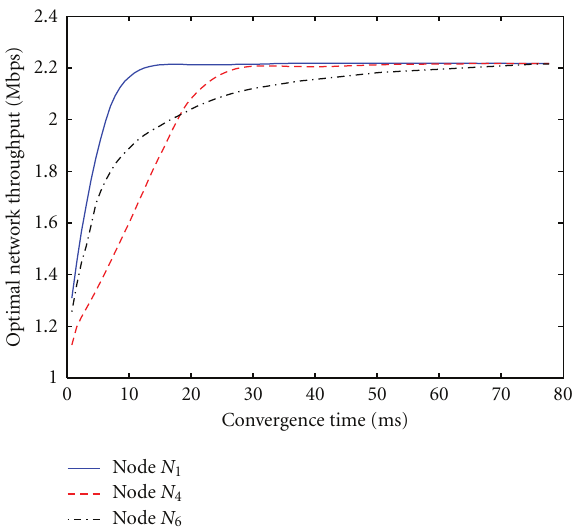
Figure 3: Convergence performance comparison for centralized implementation at the network nodes N 1 , N 4 , and N 6